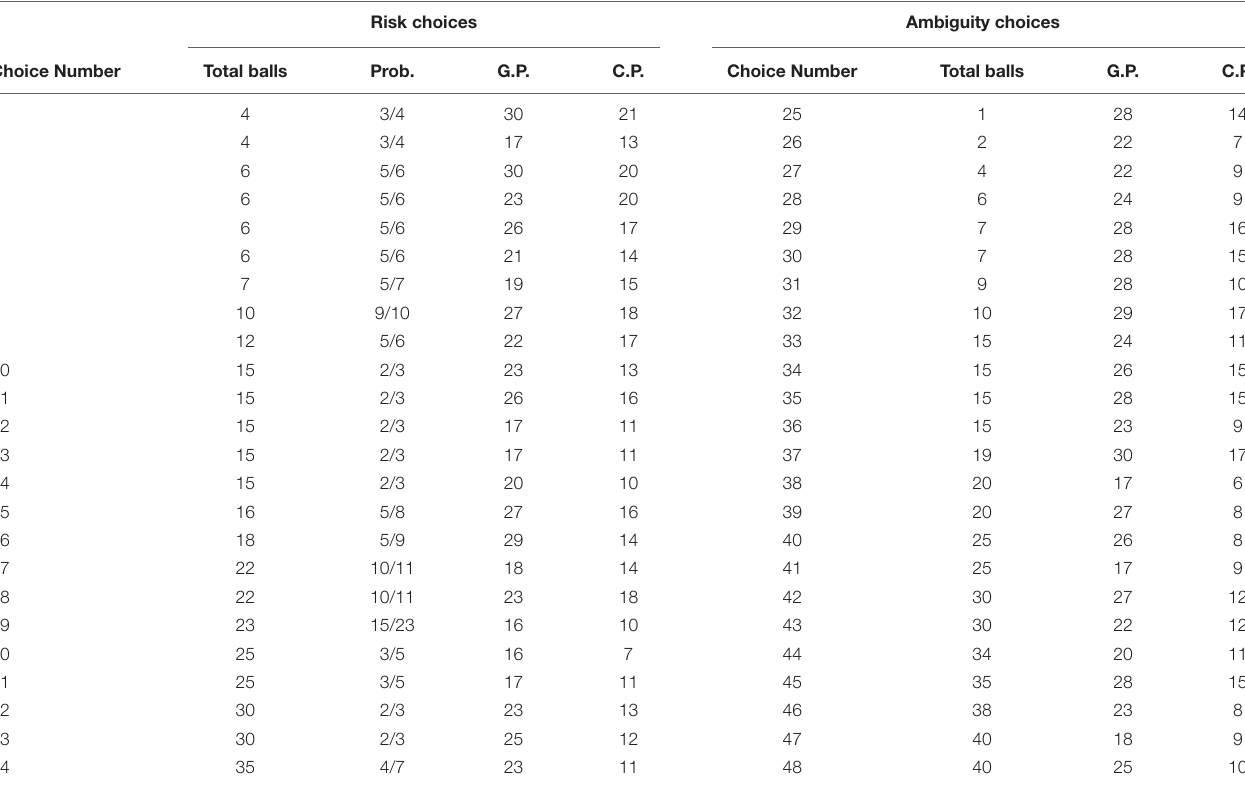
TABLE 1 | The risk/ambiguity decision-making